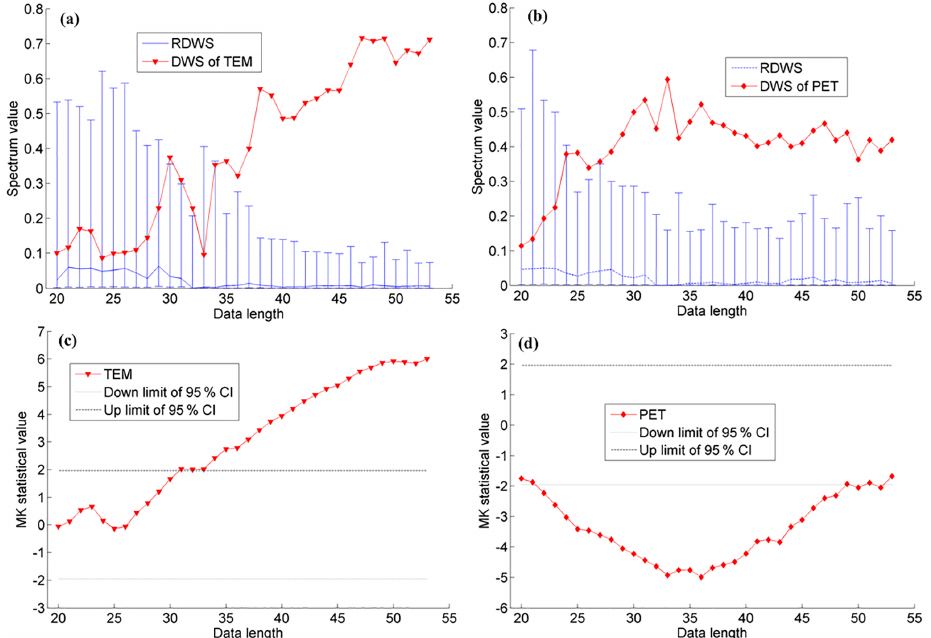
Figure 5. Evaluation of statistical significance of non-monotonic trends in the annual time series of the mean air temperature (TEM, a ) and the potential evaporation (PET, b ) over China with different data length by the discrete wavelet spectrum (DWS) approach, and the results by the Mann–Kendall (MK) test (c, d) . In panels (a) and (b) , the blue line is the reference discrete wavelet spectrum (RDWS) with 95% confidence interval under each data length and in panels (c) and (d) , the two black horizontal lines indicate the 95% confidence interval (CI) with the thresholds of ± 1.96 in the MK